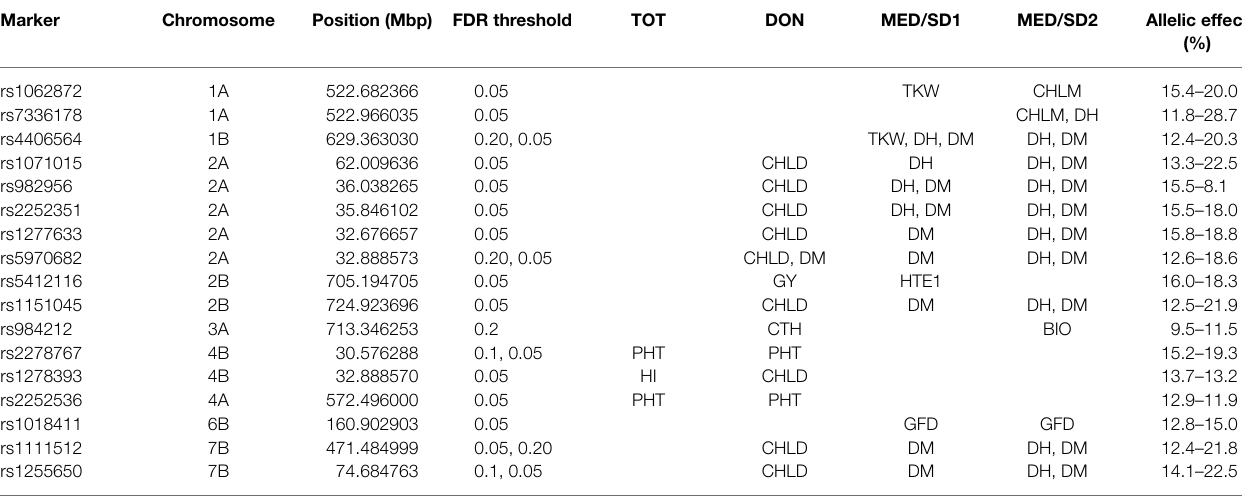
TABLE 2 | Stable and pleiotropic marker-trait associations in the four environments; Tottori (TOT), Dongola (DON), Wad Medani first sowing date (MED/SD1) and Wad Medani second sowing date (MESD/SD2) used to evaluate the multiple derivative lines (MDLs) during the 2019–20 growing season. Marker Chromosome Position (Mbp) FDR threshold TOT